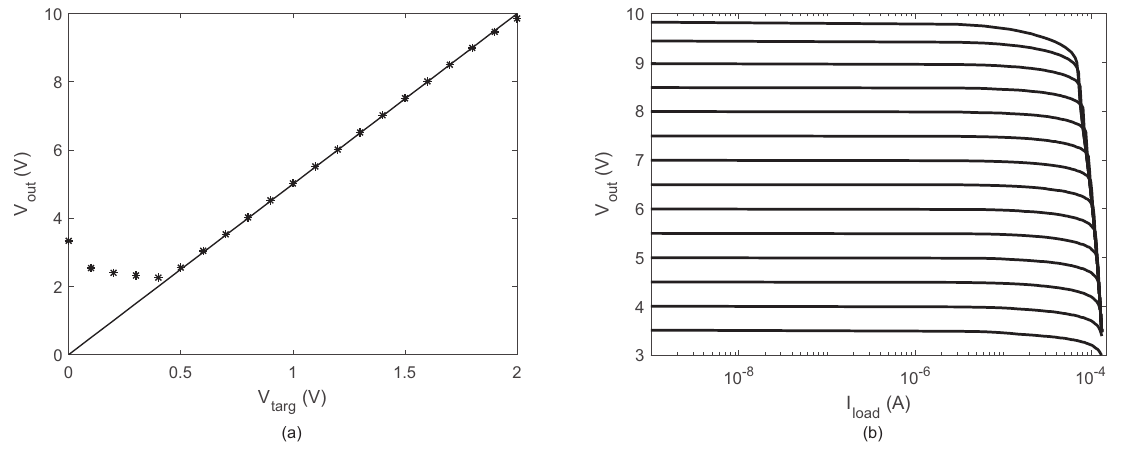
Figure 9. ( a ) Measured transfer curve from V targ to V out . ( b ) Measured load regulation of the charge pump.